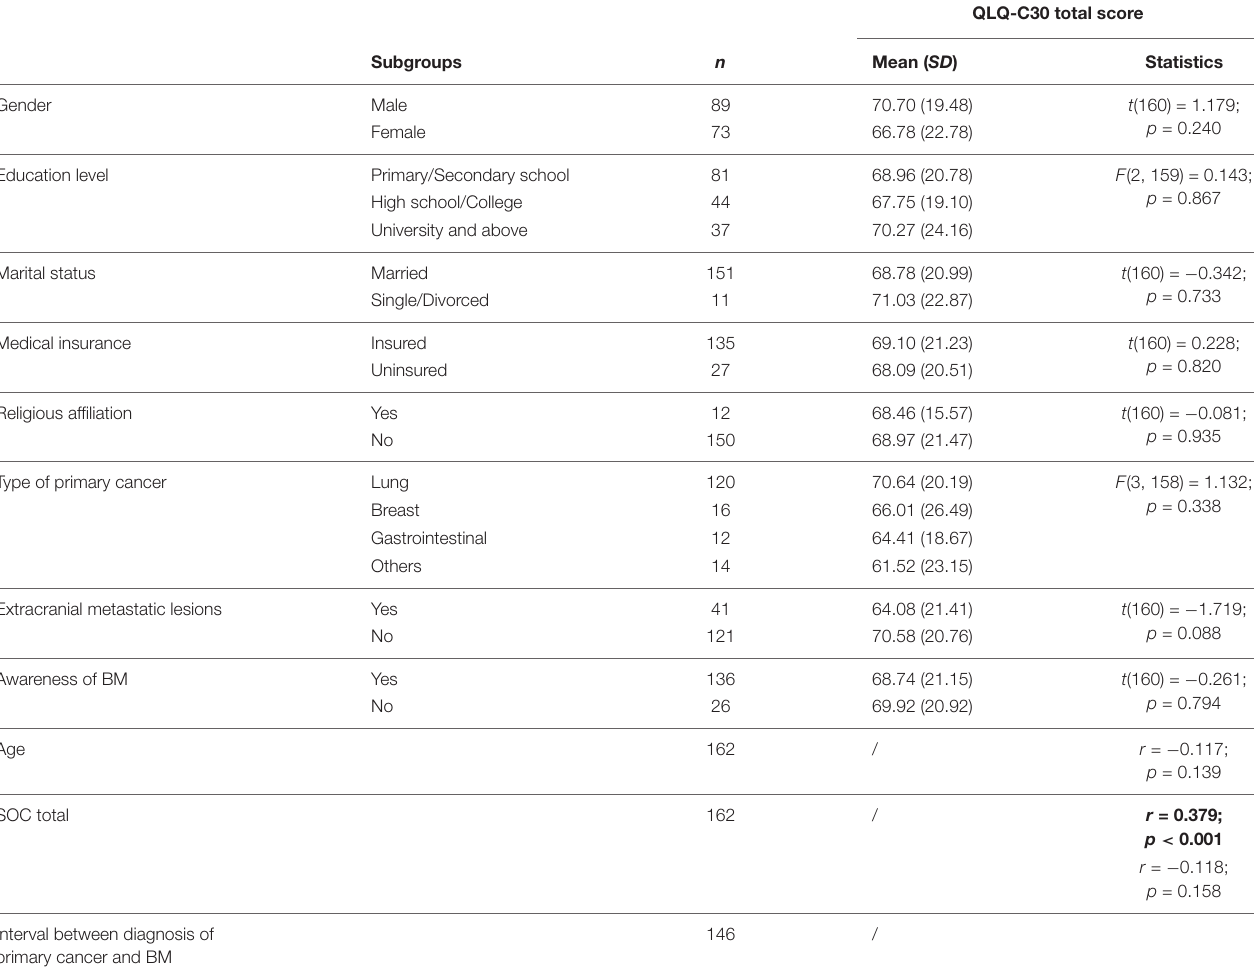
TABLE 4 | Association between sociodemographic and clinical characteristics and HRQoL in patients with